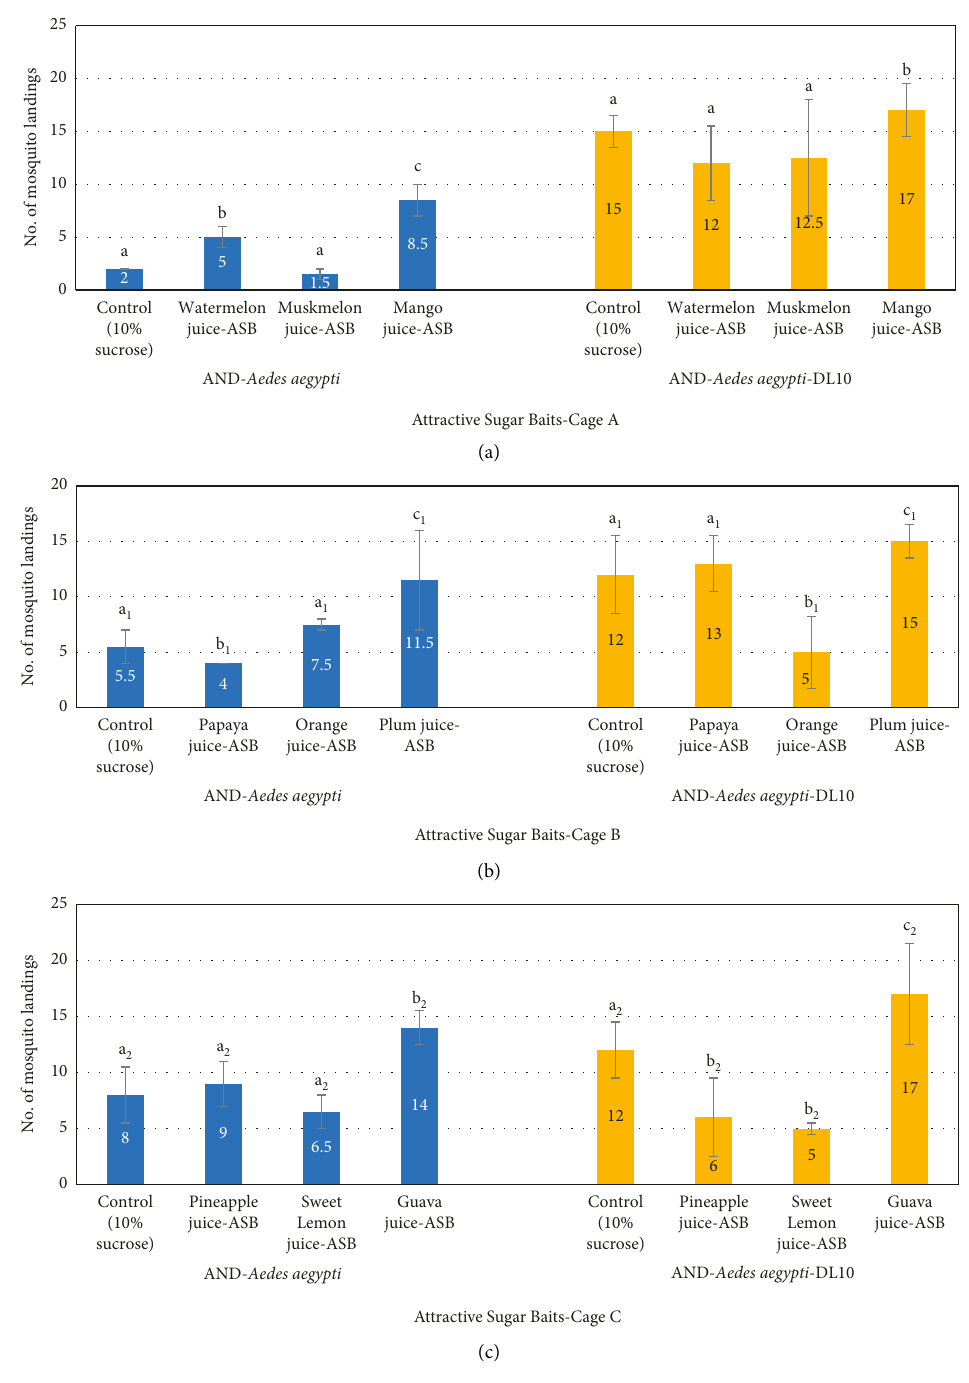
Figure 2: Screening assay showing number of landings in the laboratory population of AND- Aedes aegypti and AND- Aedes aegypti -DL10 on three ASBs placed along with a control in one of the